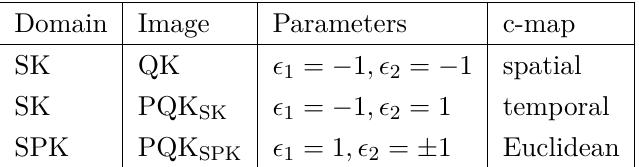
Table 4 . As far as the scalar geometries are concerned, there are three distinct c-maps. The parameters refer to the hypermultiplet ‘master Lagrangian’